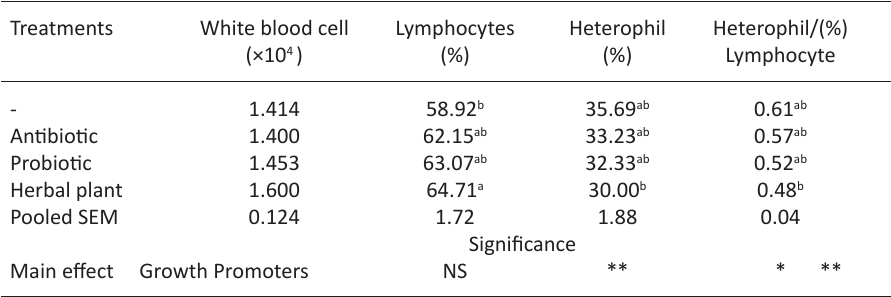
Table 5. Effects of different growth promoters on o microbial analysis of intestinal content after 40 days of broiler (CFU g -1 ) Treatments Total Count E. coli